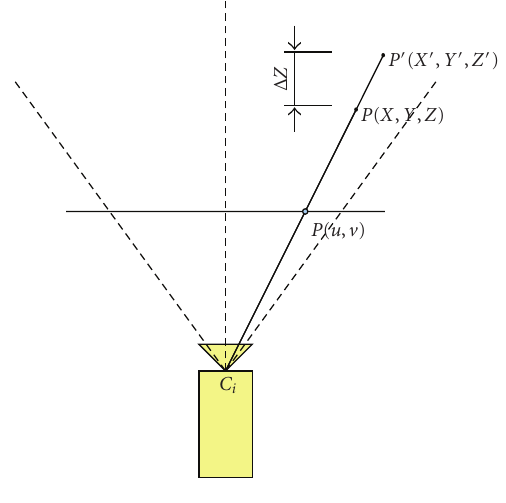
Figure 2: Pinhole camera model with depth